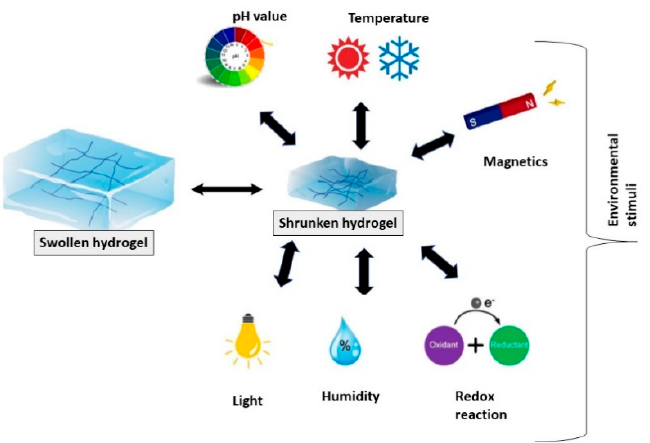
Figure 1. Schematic illustration of hydrogel biosensing application as a function of external stimuli.